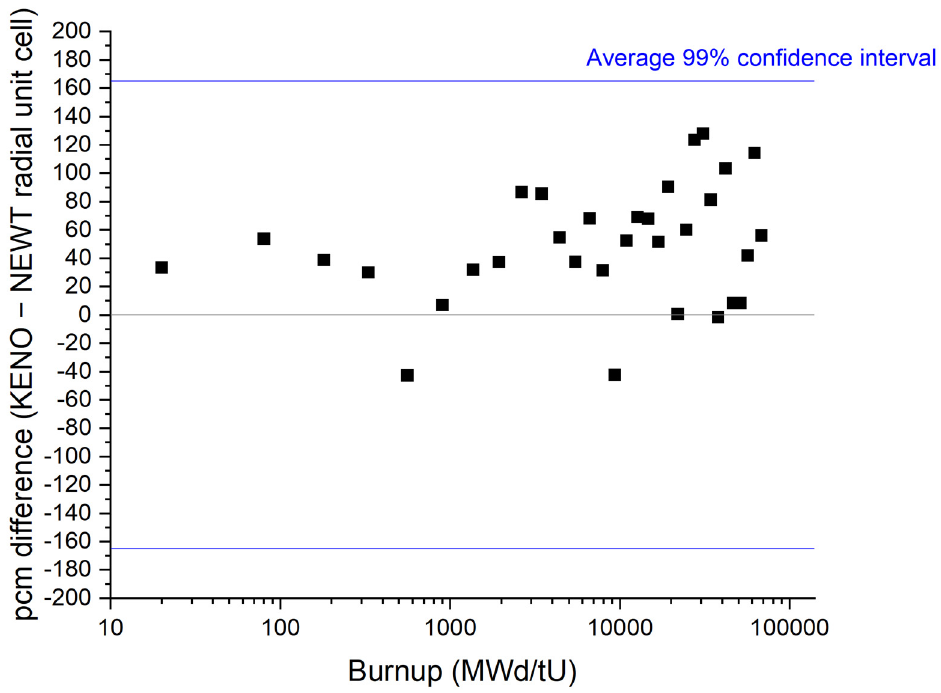
Figure 16. Difference in pcm units between the k-eff values over ~75 GWd/tU burnup between the radial unit cell model from which the RPT is calibrated, and a 3D SCALE KENO model of the same geometry and material composition. In both cases there is only a single fuel material in the pin. For the entirety of the burnup cycle the difference remains within the 165 pcm 99% confidence interval determined by the Monte Carlo statistics used in the KENO 3D model.